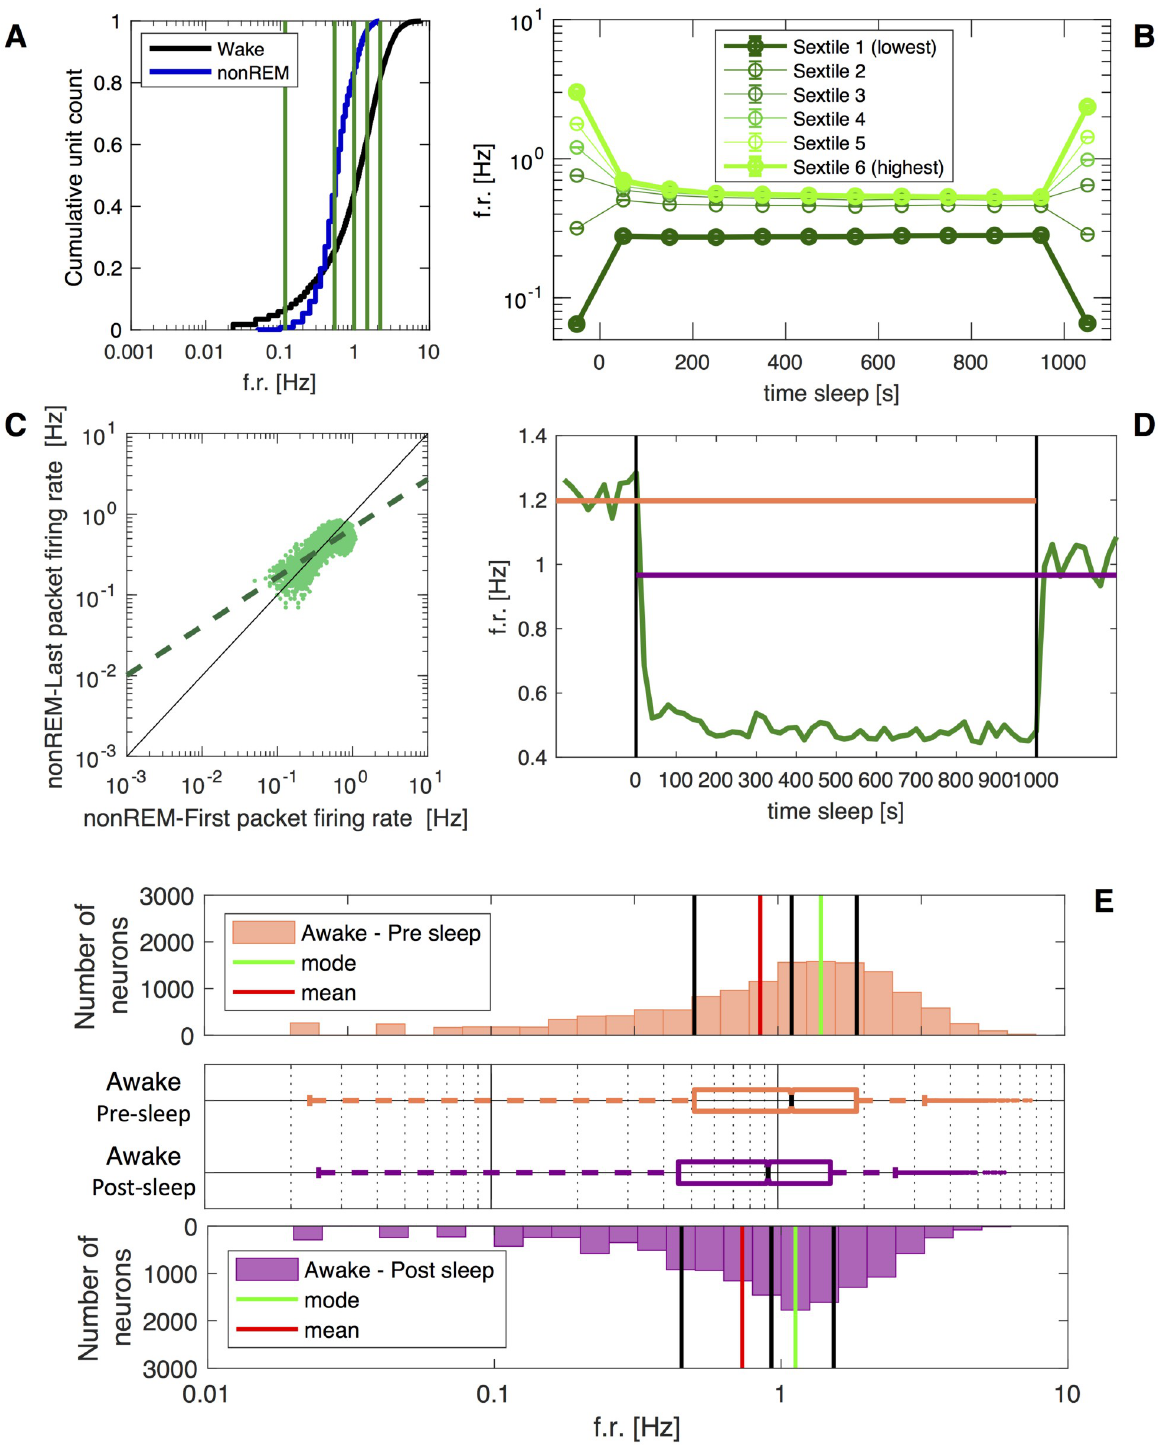
Fig 2. Sleep-like features. A) State-wise differences of average firing rate, to be compared with Fig 2A by Watson et al. [25]. Cumulative distribution of the firing rates of individual cortical neurons (log scale); note the brain-state dependent differences (colour). Vertical lines separate neurons sorted by AWAKE firing rates into six subgroups (sextiles) with an equal number of elements. B) Firing rate changes across sleep in each of the six groups defined by the awake firing rates, to be compared with Fig 3B by Watson et al. [25]. High firing rate neurons show decreasing activity; low firing rate neurons do not increase their activity over sleep. C) Opposite modulation of neurons of different firing rates, to be